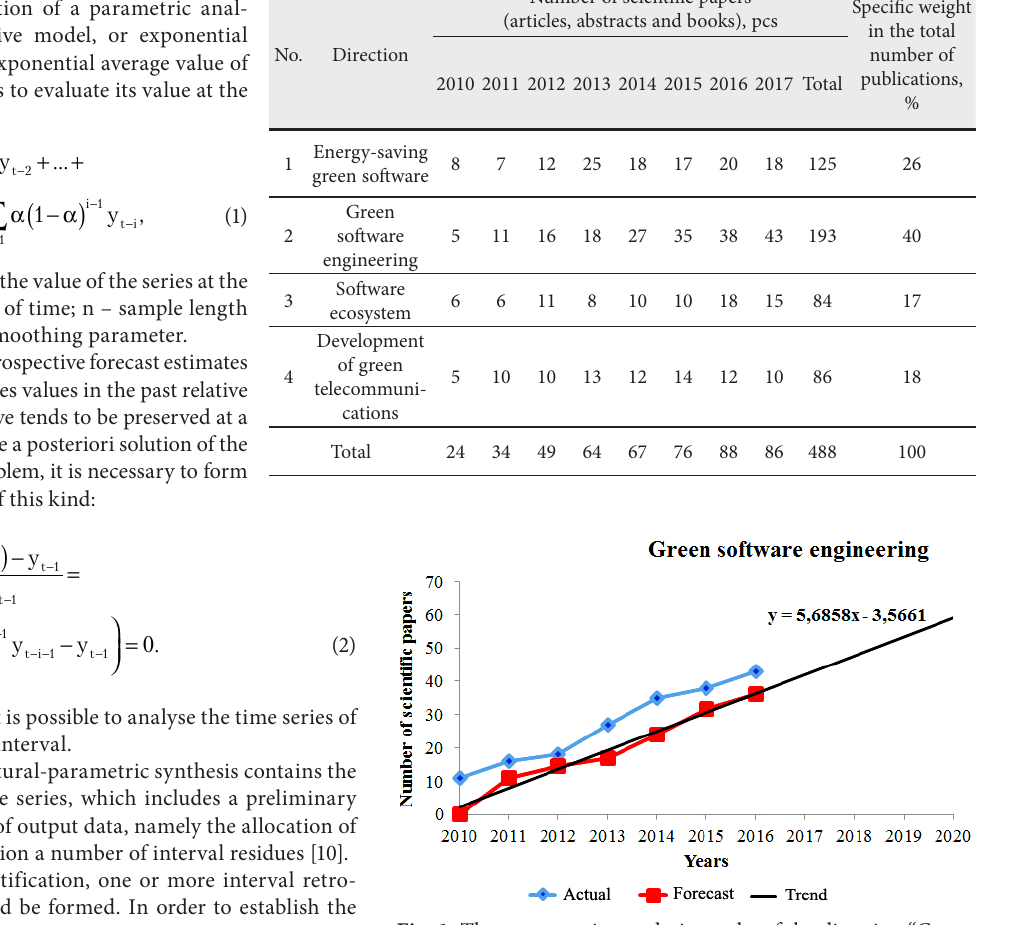
Fig. 1. The retrospective analysis results of the direction